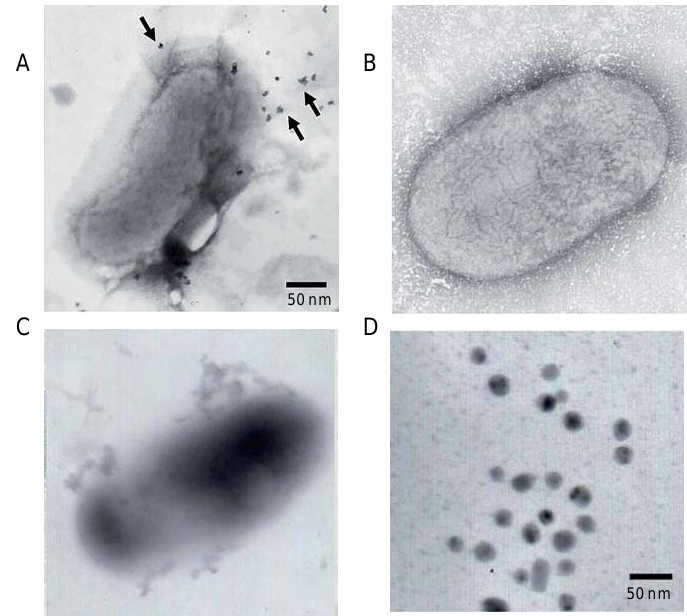
Figure 10. Eumelanine from tyrosinase induced the synthesis of gold nanoparticles. ( A ) TEM image of R. etli cell in the presence of 3-(3,4-dihydroxyphenyl)- L -alanine ( L -DOPA) and Au ions; ( B ) TEM image of R. etli cell in the presence of Au ions; ( C ) TEM image of R. etli cell in the presence of L -DOPA; ( D ) TEM of the synthesized AuNPs. Reproduced with permission from [53]. Copyright the Royal Society of Chemistry, 2014